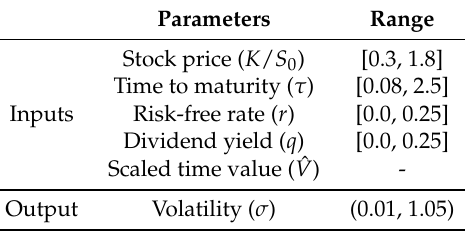
Table 2. Model parameter ranges.